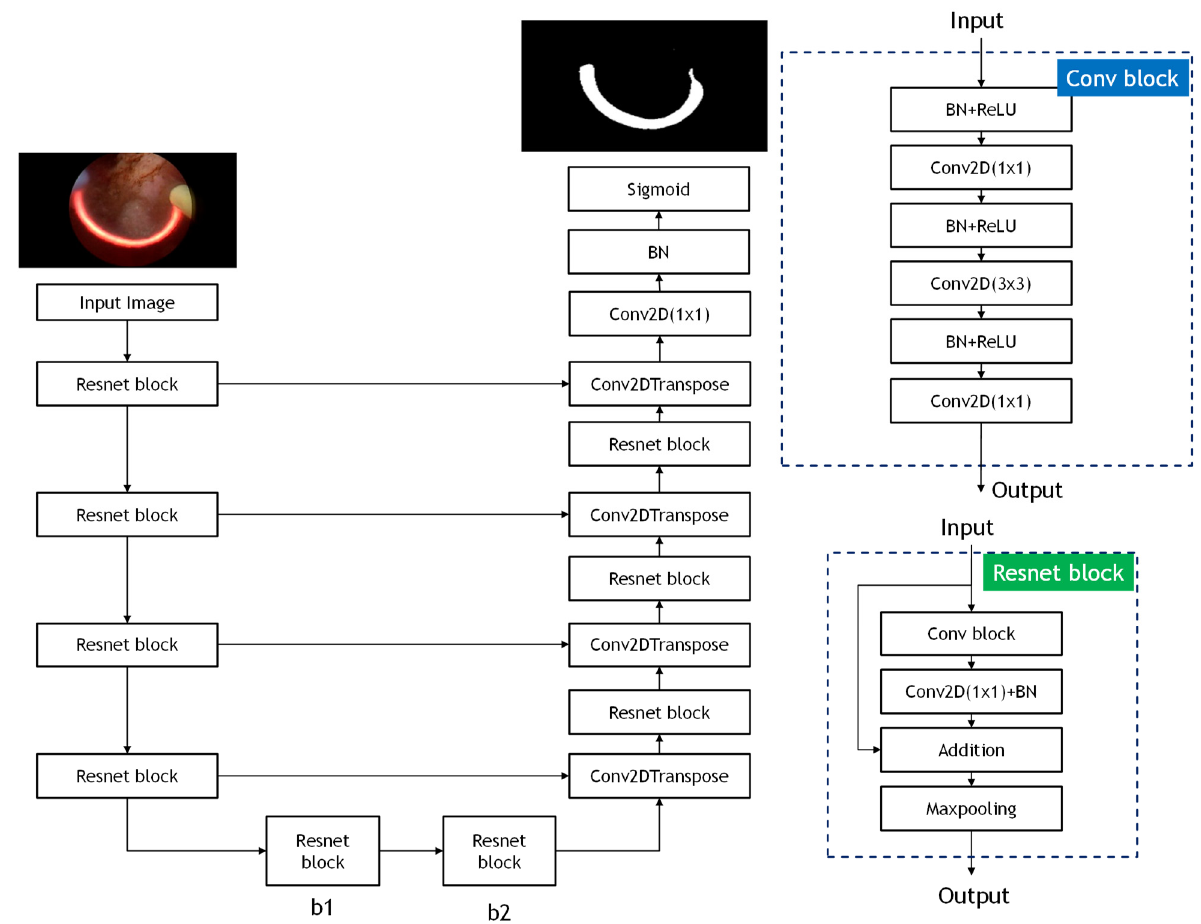
Figure 2. The structure of the ResUnet model.